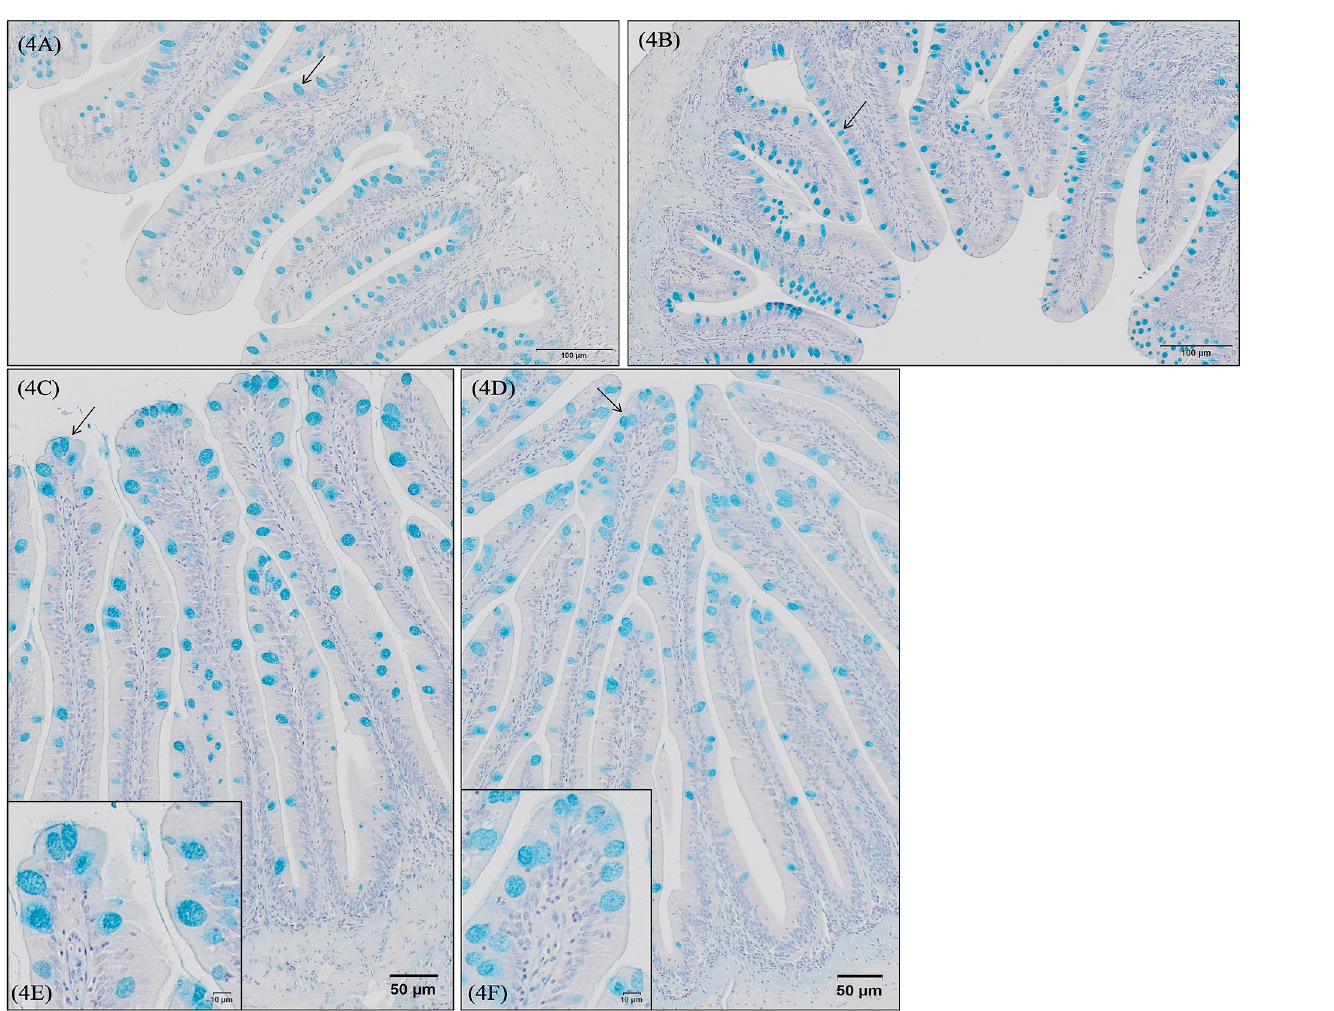
Fig 4. European sea bass ( Dicentrarchus labrax ) posterior gut and rectum goblet cell size and density after 63 days of dietary supplementation. For posterior gut (preileorectal valve), the larger goblet cells and lower density pattern is represented in Fig 4A and corresponds to fish fed control diet. Bar 100 μ m. The smaller goblet cells and higher density pattern is represented in Fig 4B and corresponds to fish fed GMOS and PHYTO diets. Bar 100 μ m. For rectum (postileorectal valve), the larger goblet cells and lower density pattern is represented in Fig 4C and 4E and corresponds to fish fed control diet. Bar 50 μ m and 10 μ m. The smaller goblet cells and higher density pattern are represented in Fig 4D and 4F and correspond to fish fed GMOS diets. Bar 50 μ m and 10 μ m. No variations were found in the % of mucosal area covered by mucus among the dietary treatments for both intestinal segments. C (control diet), GMOS (5000 ppm galactomannan oligosaccharides), PHYTO (200ppm